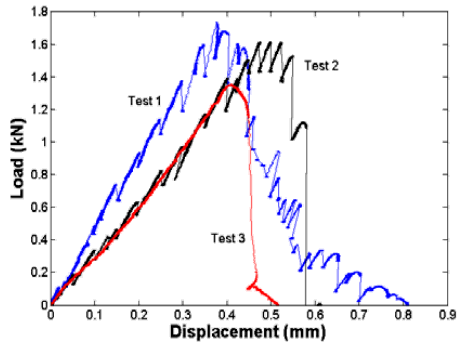
Figure 5. Experimental load vs. displacement curves for the three four ‐ point bending tests conducted.